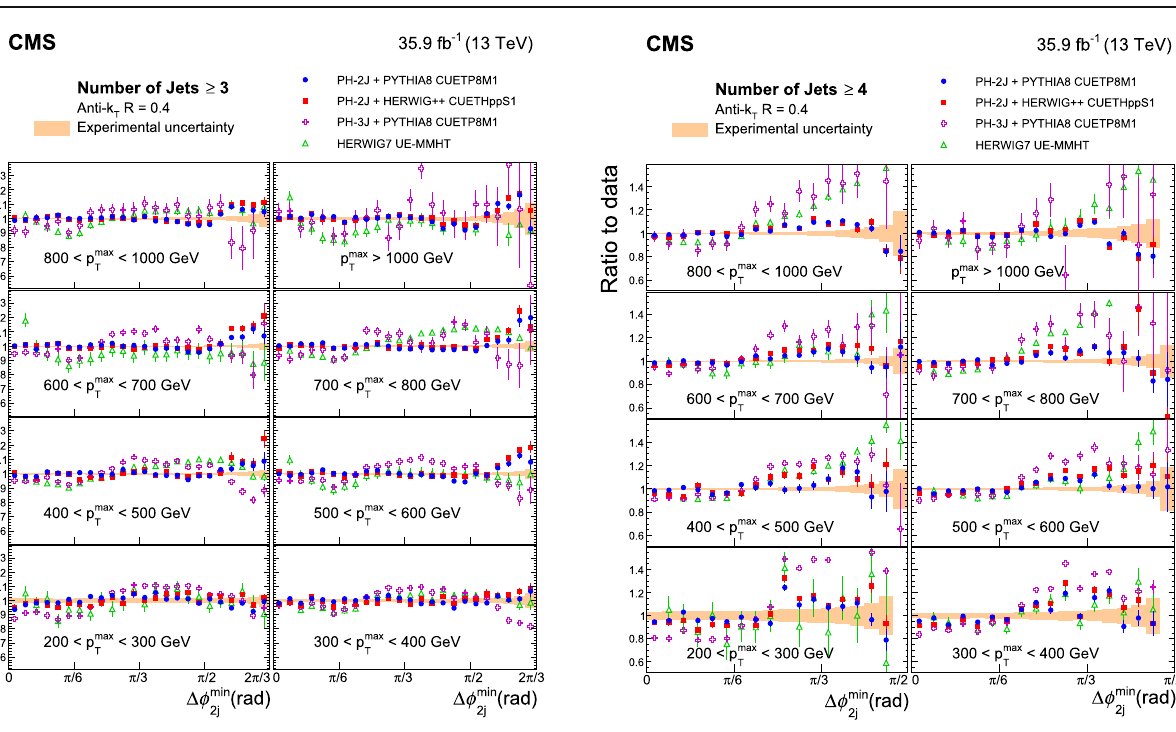
Δφ 1,2 measurements, showing improvement in comparison to herwig++